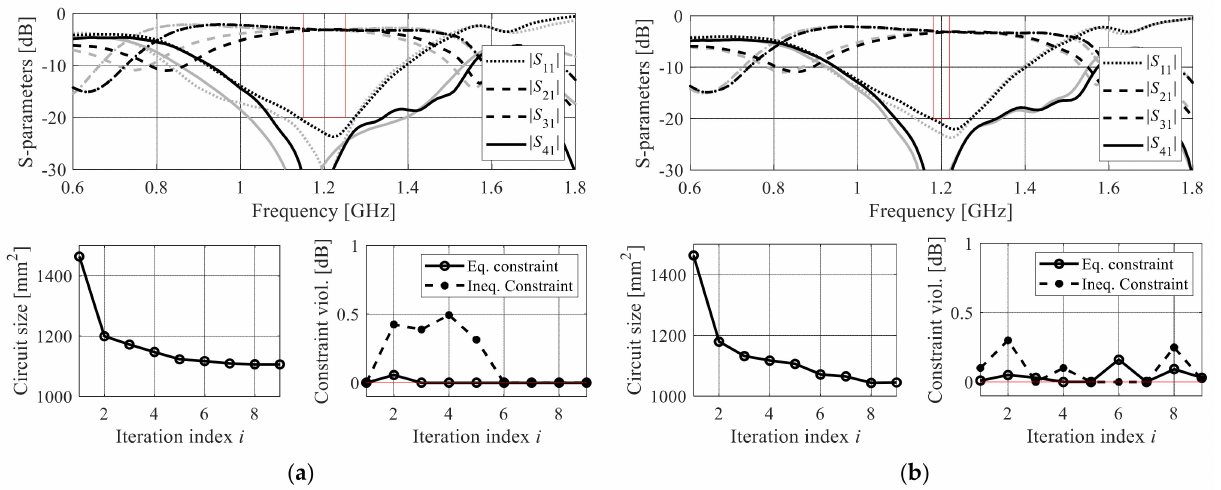
Figure 14. Initial (gray) and optimized (black) S-parameters of the circuit of Figure 13. The vertical and horizontal lines mark the target operating bandwidth and the acceptance level for the matching | S 11 | and isolation | S 41 | responses. Additionally, shown is the evolution of the circuit size and constraint violations (in case of feasibility, violations shown as zero): ( a ) design scenario I